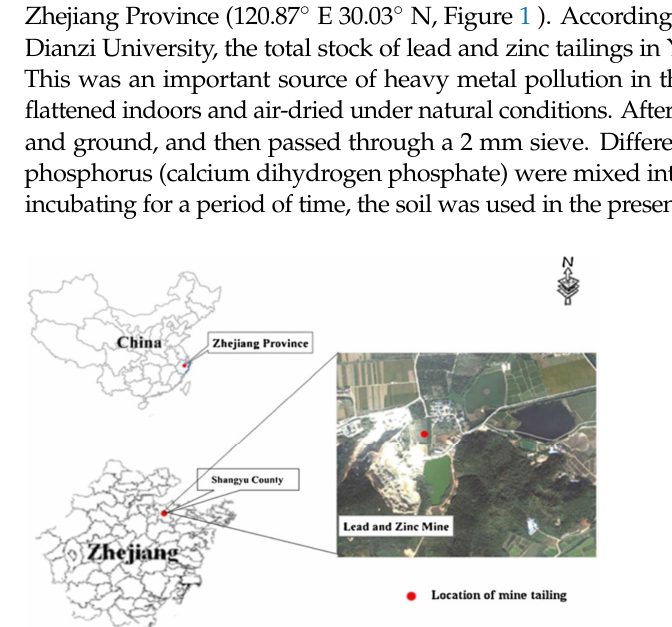
Table 1. Physical and chemical properties of the tested soil samples. Items